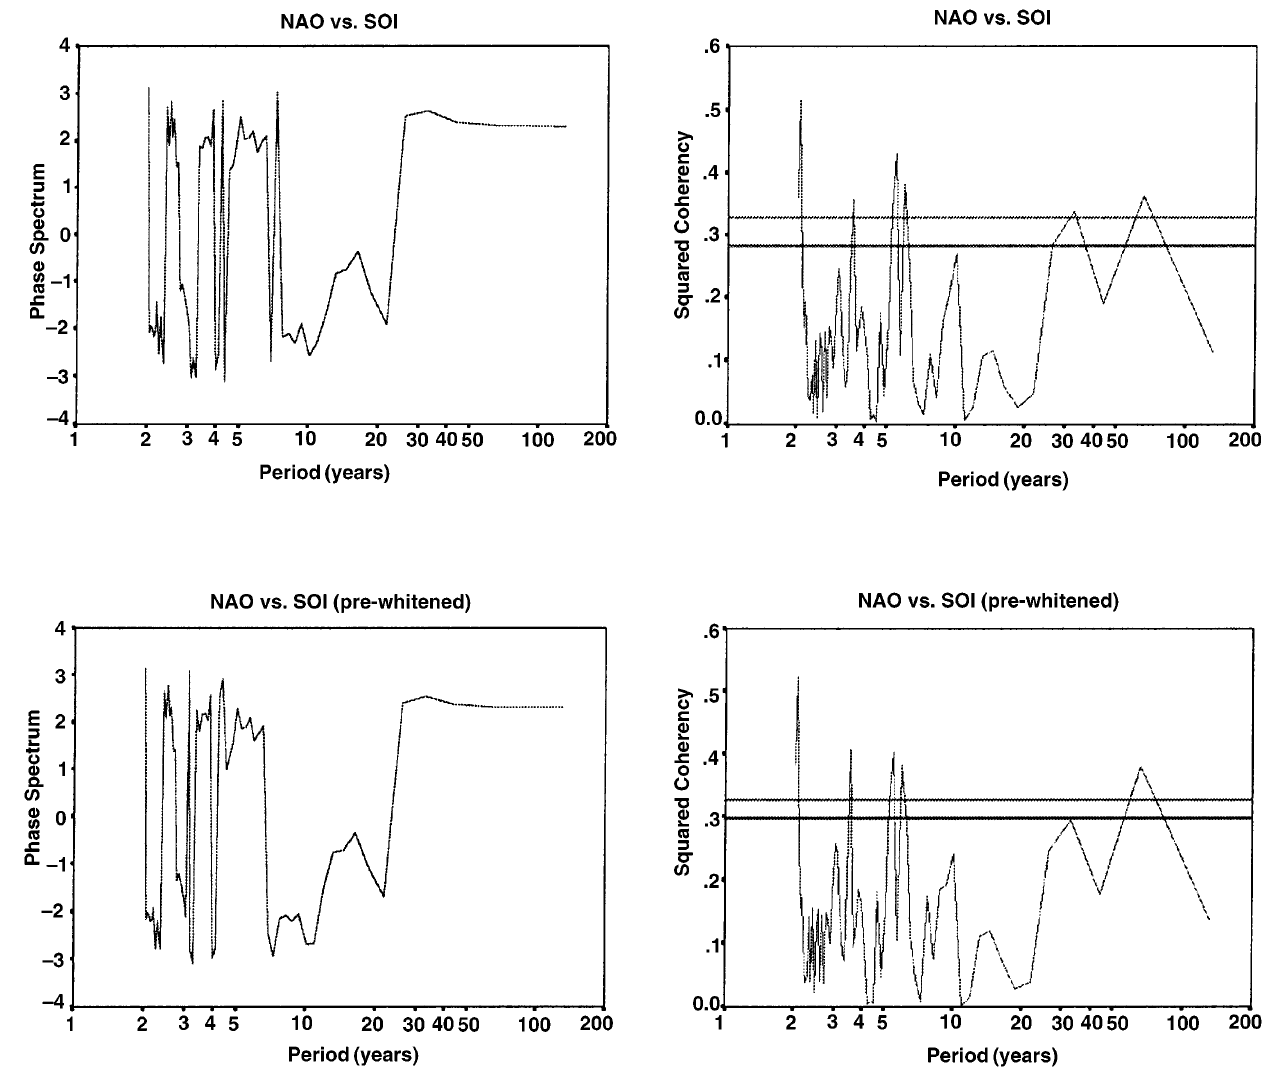
Fig. 4. Cross-spectrum (phase spectrum and squared coherency of NAO vs. SOl with and without pre-whitening. In the squared coherency spectrumtwosignificancelevelsareshown(95%),thelowercomputedfromJenkins-WattsandthehigherfromaMontecarlotest(seedetailsintext)